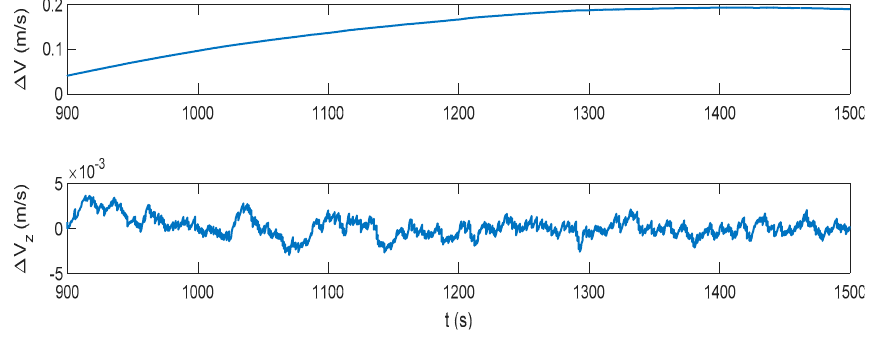
Figure 17. Velocity error of the IMM-aided ZUPT solution during the DVL outage. Sensors 2017 , 17 , 2030